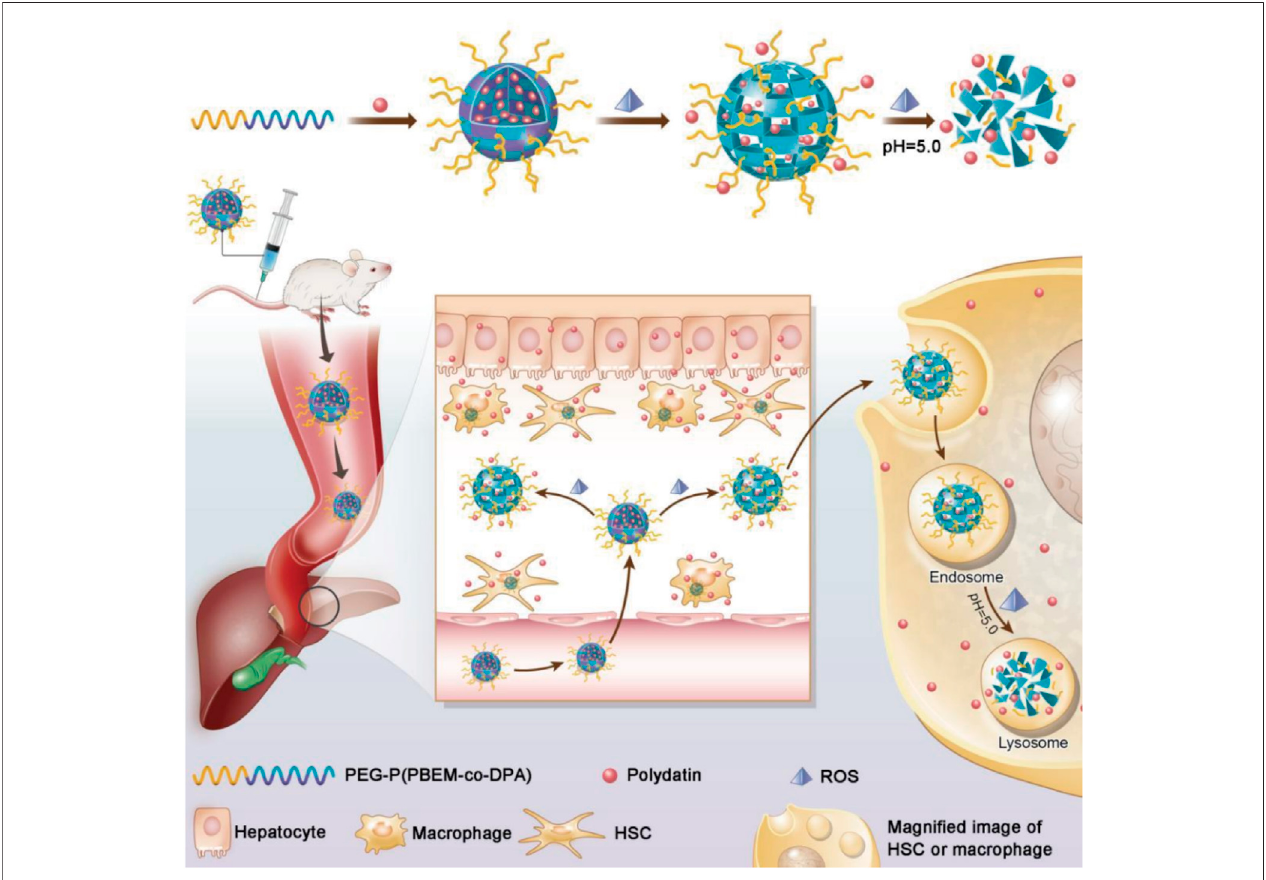
FIGURE 4 | Schematic illustration of PEG-P (PBEM-co-DPA)-Polydatin, a ROS, and pH dual-responsive nanodrug that regulates multiple cell types for the treatment of liver fi brosis (Lin et al., 2020).